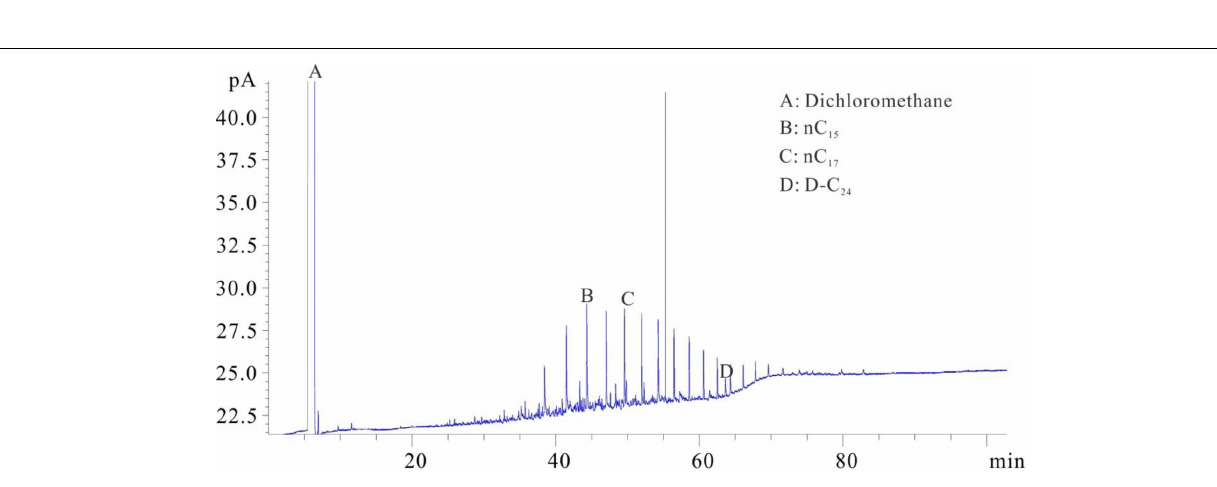
FIGURE 3 | Chromatogram of samples that were soaked first and then evaporated (chromatogram after step 3).